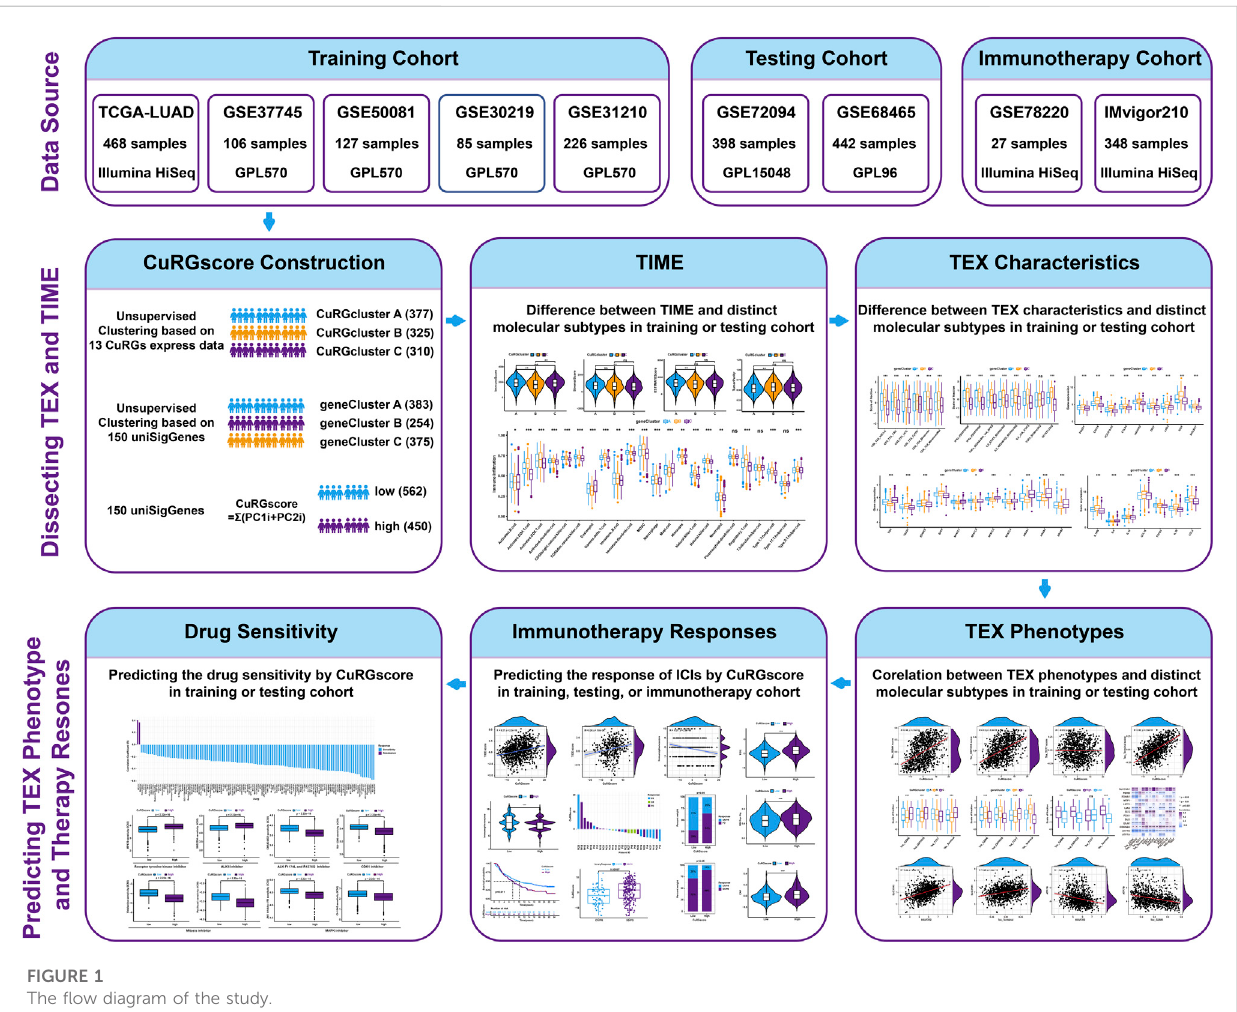
FIGURE 1 The fl ow diagram of the